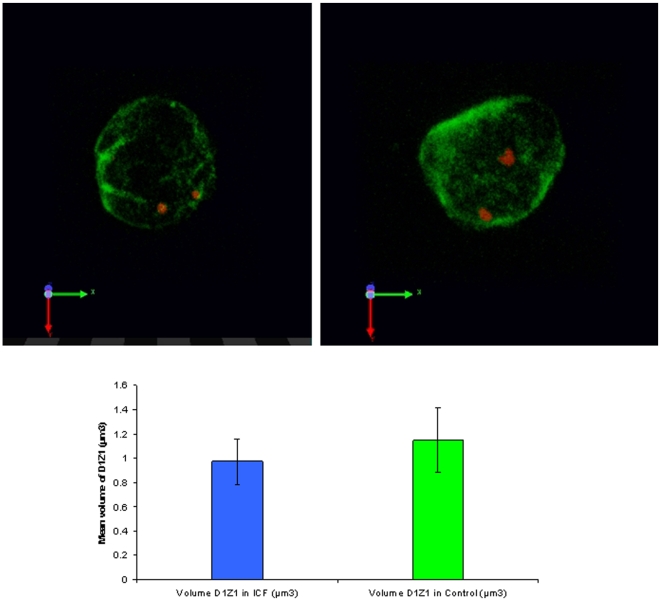
Chromosome 1 juxtacentromeric heterochromatin: volume measurements in ICF cells and controls.The nuclear volumes occupied by the chromosome 1 juxtacentromeric heterochromatin, as defined by hybridisation with the D1Z1 classical satellite DNA probe (red) on 3D-fixed interphase nuclei (immunostained with anti-Lamin B, green), were measured and compared in ICF Patient 1 and Control 1 as described in the Materials and Methods. The heterochromatin was shown to occupy on average a smaller volume in ICF cells. The data sets were compared using a Kolmogorov-Smirnov test, which revealed a statistically significant difference between the ICF and Control volume distributions (D = 0.2356, P<0.001). Examples of variable heterochromatin patterns as observed by 3D-FISH, confocal analysis and volume reconstruction are shown in the top panels.